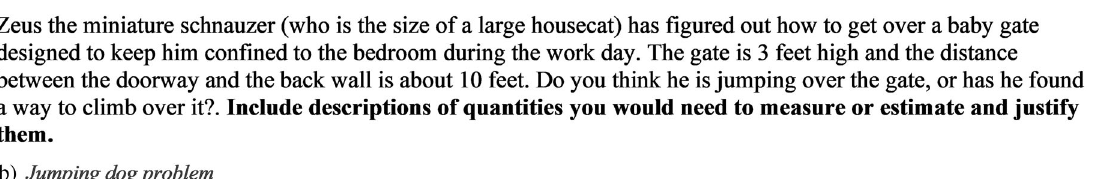
FIG. 2. (a) The Atwood machine problem from the 2018 final exam in Physics 41, and (b) the jumping dog problem from the think- aloud interviews conducted in